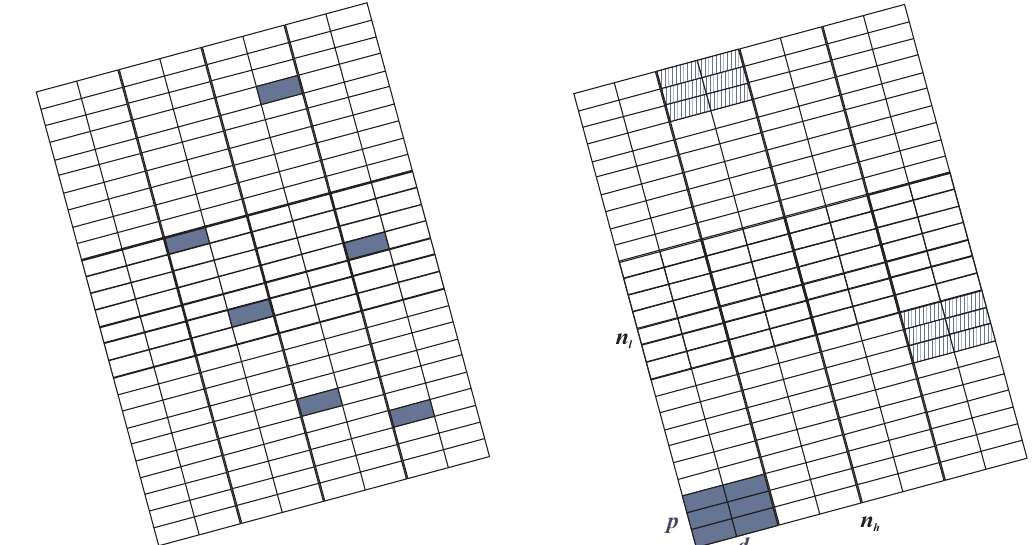
Figure 6. Land plots consolidation by the formation of a land tenure of the defined configuration and placement at the land mass